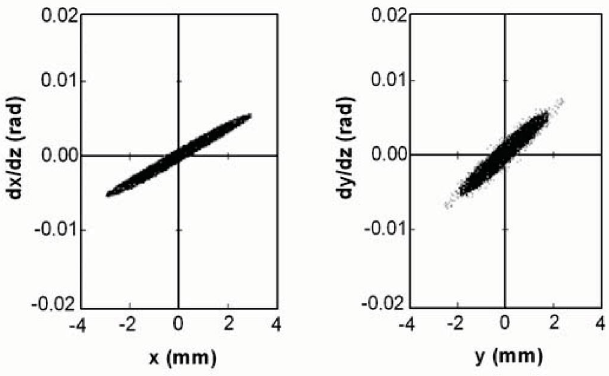
FIG. 10. Phase portrait behind deflector.